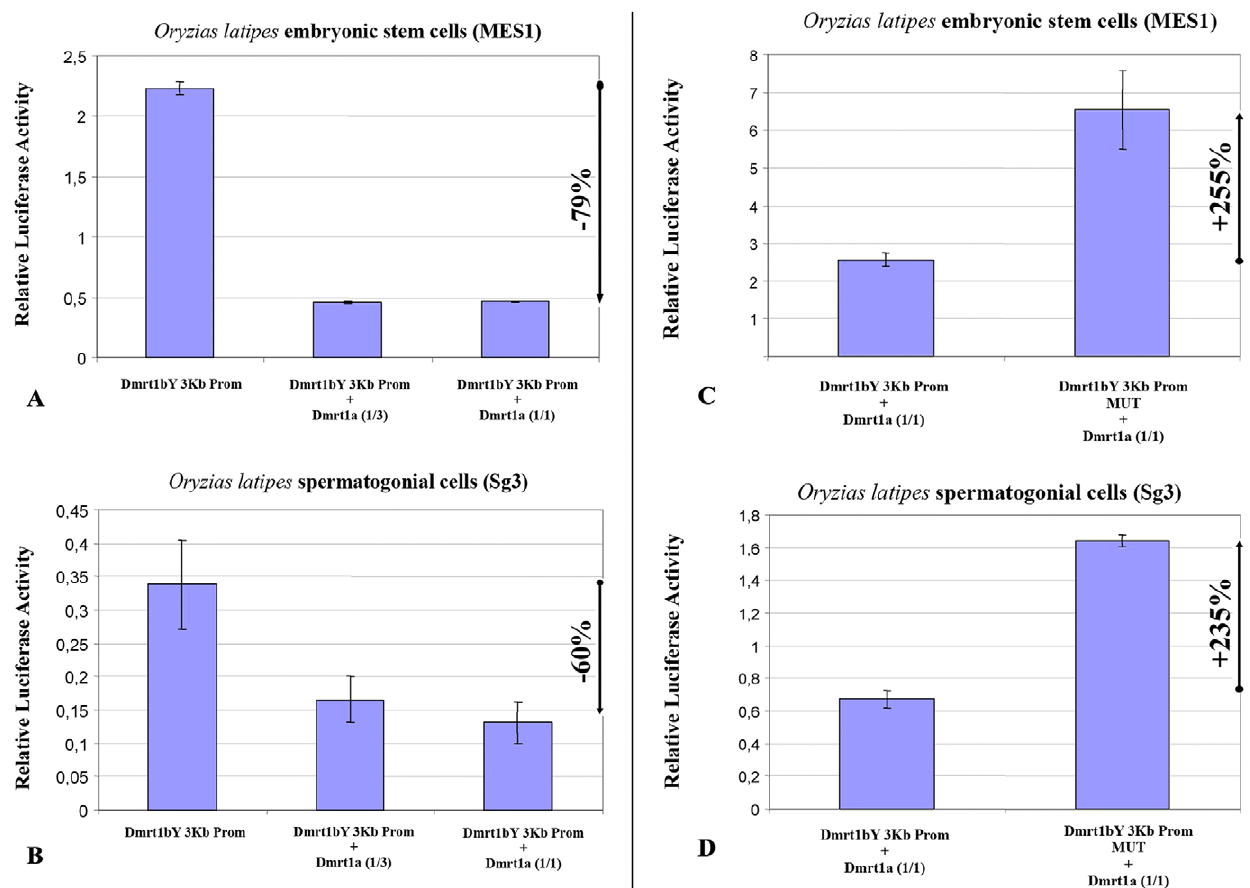
Figure 3. Transient-transfection analysis of dmrt1bY promoter activity when co-transfected with different ratios of a Dmrt1a expressing plasmid. (A,B) The 3 Kb proximal dmrt1bY promoter construct was co-transfected with different amounts of dmrt1a -expressing plasmid (1:3 and 1:1 ratios). (C,D) The 3 Kb mutant proximal dmrt1bY promoter construct was co-transfected with different amounts of dmrt1a -expressing plasmid (1:3 and 1:1 ratios). The data are presented as the firefly/Gaussia luciferase activity. Transfections were done three times; error bars represent the standard errors of the means.